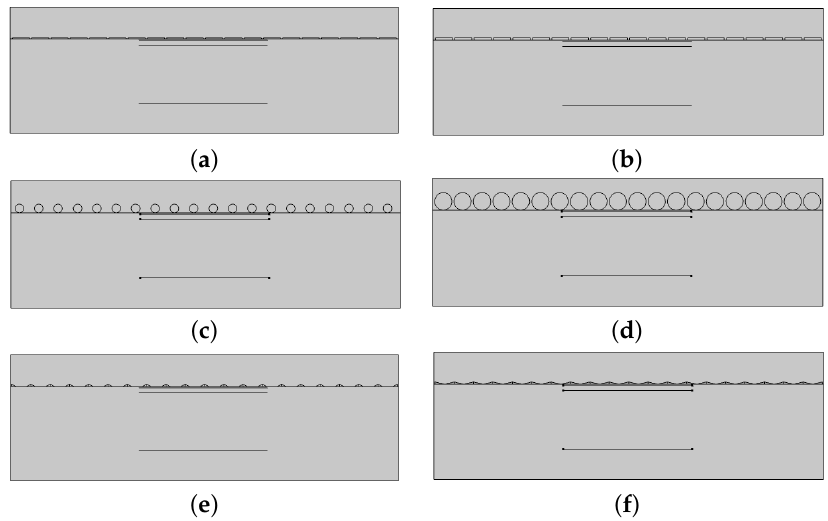
Figure 2. The different structure designs. ( a ) Rectangular structure with 20 nm thickness. ( b ) Rectan- gular structure with 50 nm thickness. ( c ) Circular structure with 100 nm radius. ( d ) Circular structure with 200 nm radius. ( e ) Triangular structure with 100 nm base and 50 nm height. ( f ) Triangular structure with 200 nm base and 50 nm height.